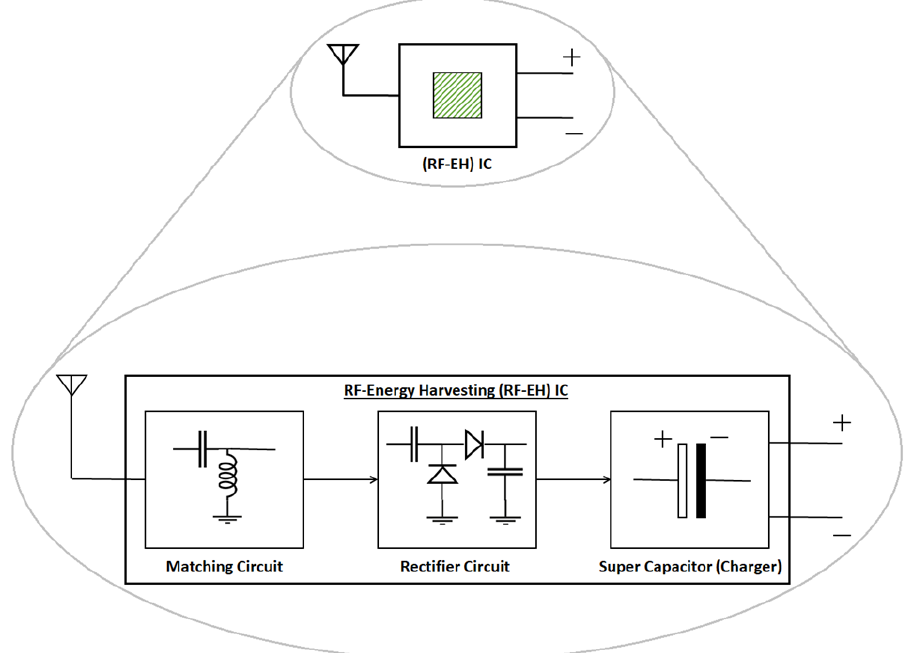
Figure 2. The miniaturization concept of RF-EH modules into micro- or nano-meter-sized ICs is depicted herein. As its working principle, an RF antenna absorbs the ambient (or specific band(s) of) RF signal and converts its energy into the equivalent DC type of output